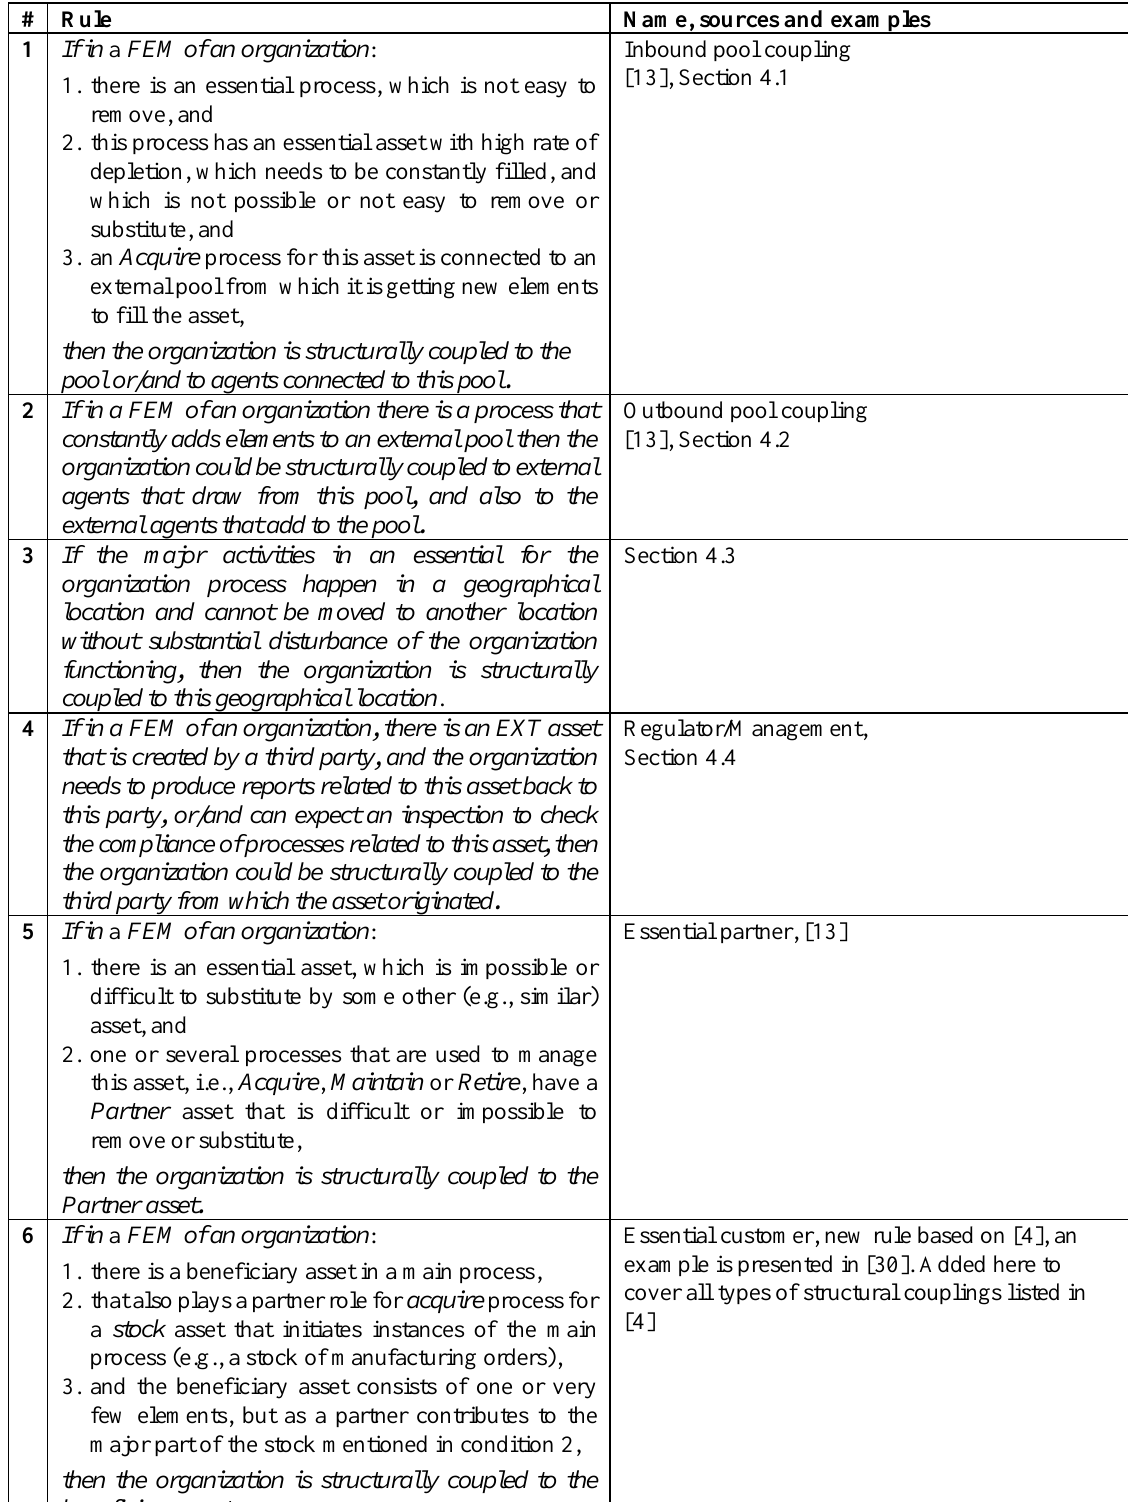
Table 4. Rules for detecting structural